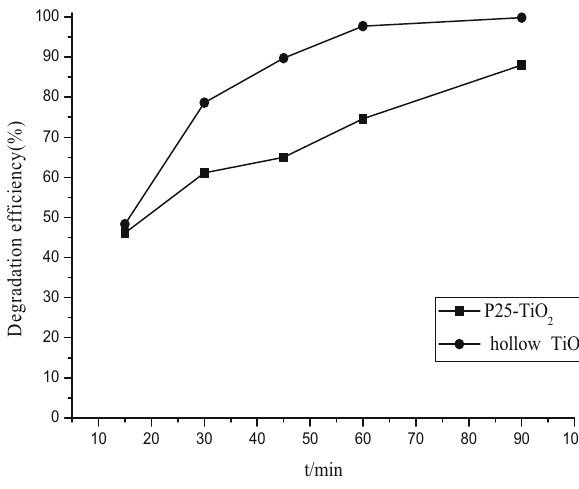
Figure 10: Photocatalytic activity of prepared hollow TiO 2 micro - spheres and P25 - TiO 2